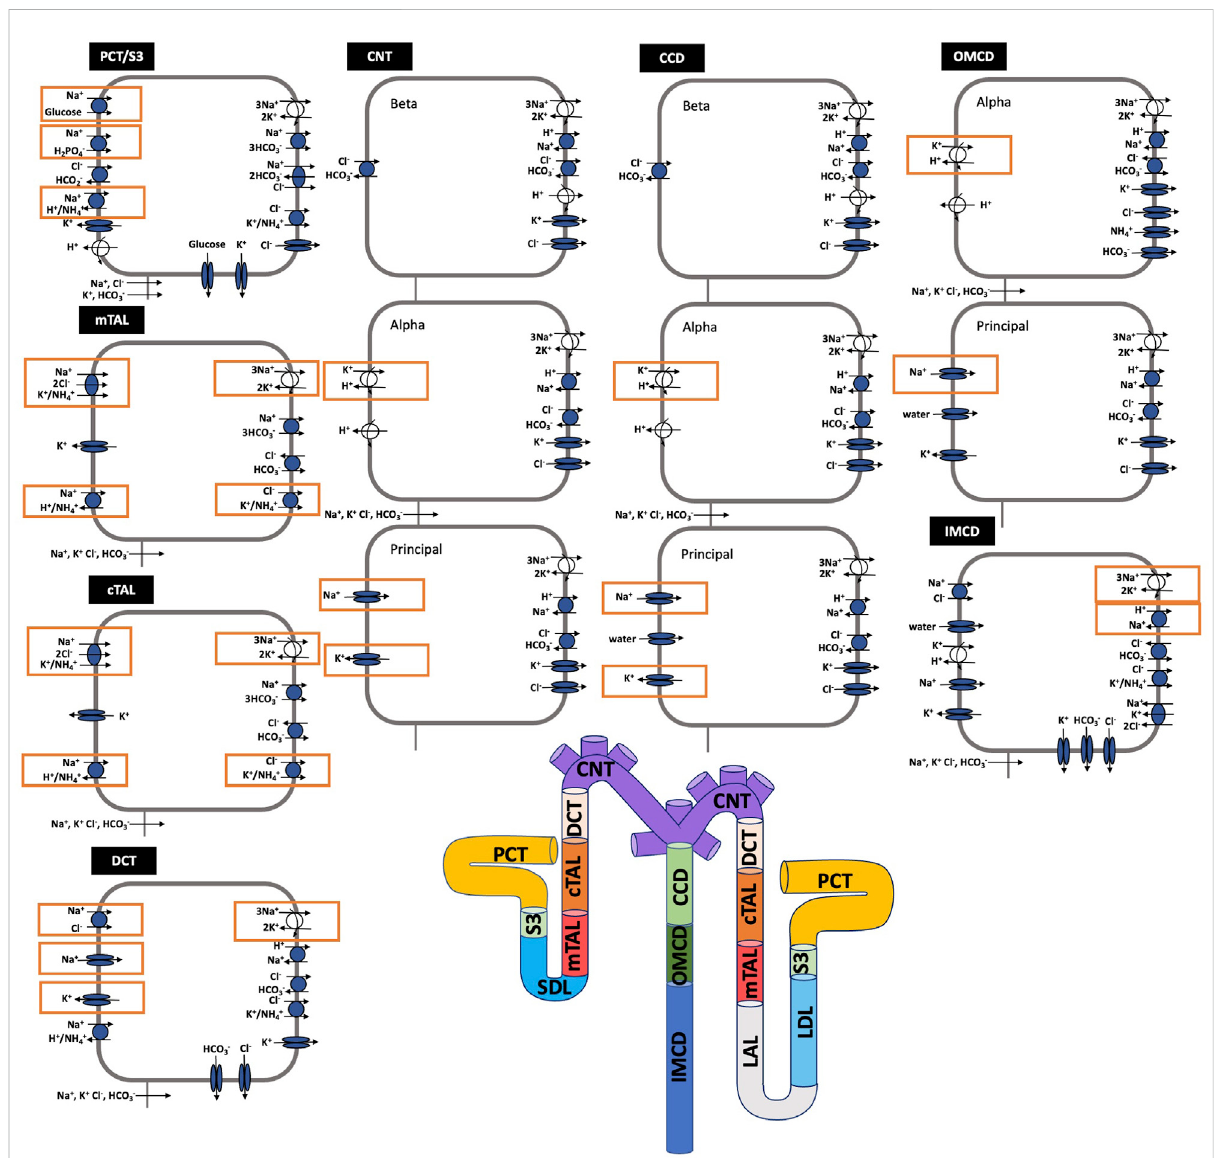
Schematic diagram of the nephron system (not to scale). Model structure is similar for the rat and mouse. The model includes one representative super fi cial nephron and fi ve representative juxtamedullary nephrons, each scaled by the appropriate population ratio. Only the super fi cial nephron and one juxtamedullary nephron are shown. Along each nephron, the model accounts for the transport of water and 15 solutes (see text). The distal tubule is divided into the early and late portions of the distal convoluted tubule (DCT). The diagram displays only the main Na + , K + , and Cl − transporters. Transporters that are parameterized differently betweenthe rat and mouse are highlightedin red boxes. PCT, proximal convoluted tubule; SDL, short or outer medullary descending limb; mTAL, medullary thick ascending limb; cTAL, cortical thick ascending limb; CNT, connecting tubule; CCD, cortical collecting duct; OMCD, outer-medullary collecting duct; IMCD, inner medullary collecting duct; LDL, thin descending limb; LAL, thin ascending limb. Reprinted with permission from Ref. (Layton et al.,